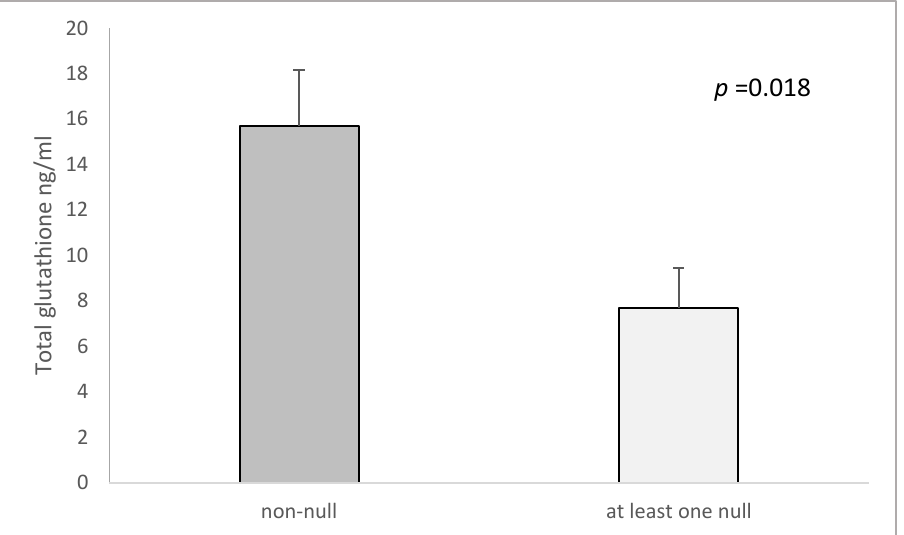
Figure 4. Total glutathione levels in controls according to GSTM1 genotypes. The total glutathione is presented as mean ± standard error of mean (SEM).